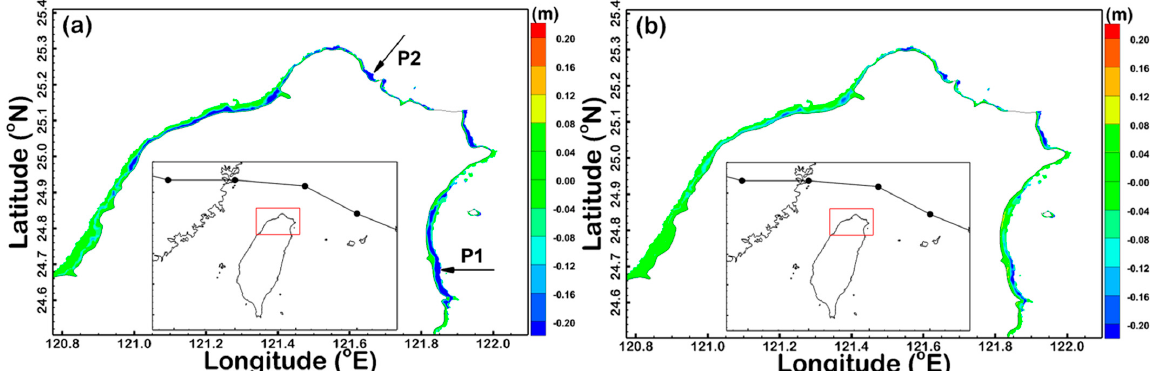
Figure 13. Spatial distribution of the difference in the maximum SWH between the scenarios of ( a ) S_NO1 and S_NO4 and ( b ) S_NO1 and S_NO5 during the passage of Super Typhoon Maria in 2018. The areas with water depths greater than − 20 m are shown.